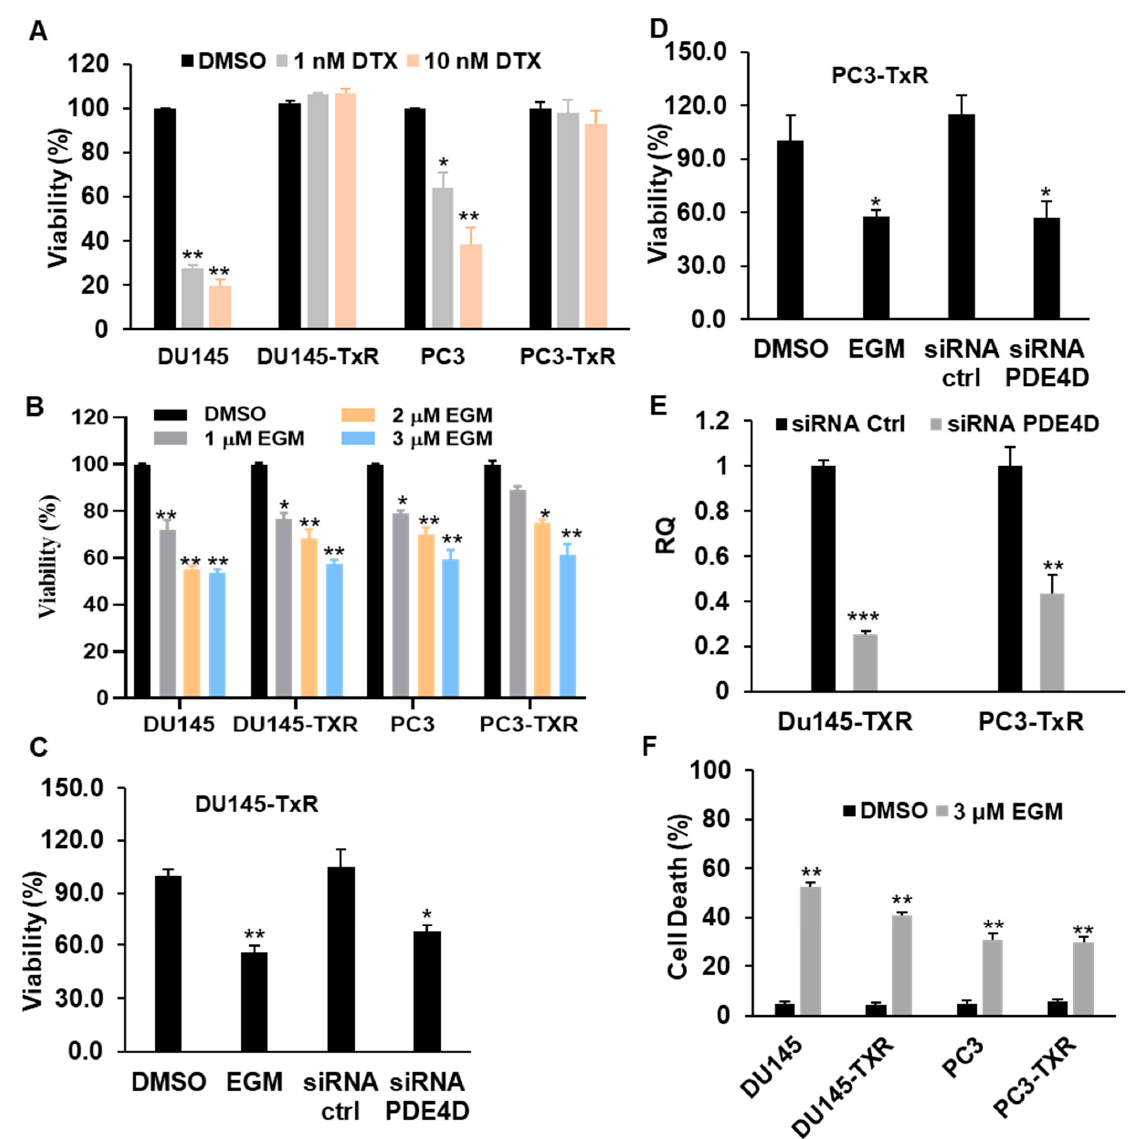
Figure 3. Eggmanone reduces proliferation and induces death of chemo-resistant prostate cancer cells. ( A ) The chemo-sensitive prostate cancer DU145 and PC3 cells and the chemo-resistant prostate cancer DU145-TxR and PC3-TxR cells were treated with DMSO vehicle, docetaxel at 1 nM and 10 nM concentrations for 72 h, respectively. The cell viability (%) was normalized with DMSO vehicle treated cells, and the result indicated that docetaxel treatment dramatically down-regulated cell viabilities of the chemo-sensitive DU145 and PC3 but not chemo-resistant DU145-TxR and PC3-TxR cells (up to 10 nM). ( B ) The chemo-sensitive prostate cancer DU145 and PC3 cells and the chemo-resistant prostate cancer DU145-TxR and PC3-TxR cells were treated with DMSO vehicle, Eggmanone at 1 µM, 2 µM and 3 µM concentrations for 72 h. The cell viability (%) was normalized with DMSO vehicle treated cells, and the result indicated that Eggmanone treatment dramatically down-regulated cell viabilities of both chemo-sensitive and chemo-resistant prostate cancer cells ( C ) DU145-TxR and ( D ) PC3-TxR cells were treated with DMSO vehicle, 3 µM Eggmanone, siRNA control and siRNA PDE4D, and the cell viability was assayed after 72 h. ( E ) RT-PCR result indicates that PDE4D was effectively knock downed (approximately 75% gene knockdown for DU-145-TxR and 58% for PC3-TxR). ( F ) The chemo-sensitive prostate cancer DU145 and PC3 cells and the chemo-resistant prostate cancer DU145-TxR and PC3-TxR cells were treated with DMSO vehicle, Eggmanone at 3µM concentrations for 72 h, the cells were harvested for cell death assay using Trypan Blue staining. The result showed that 3 µ M Eggmanone significantly reduced cell deaths in both chemo-sensitive and chemo-resistant prostate cancer cells ( n = 3, ** p < 0.01). For each experiment ( n = 3, * p < 0.05, ** p < 0.01, *** p <